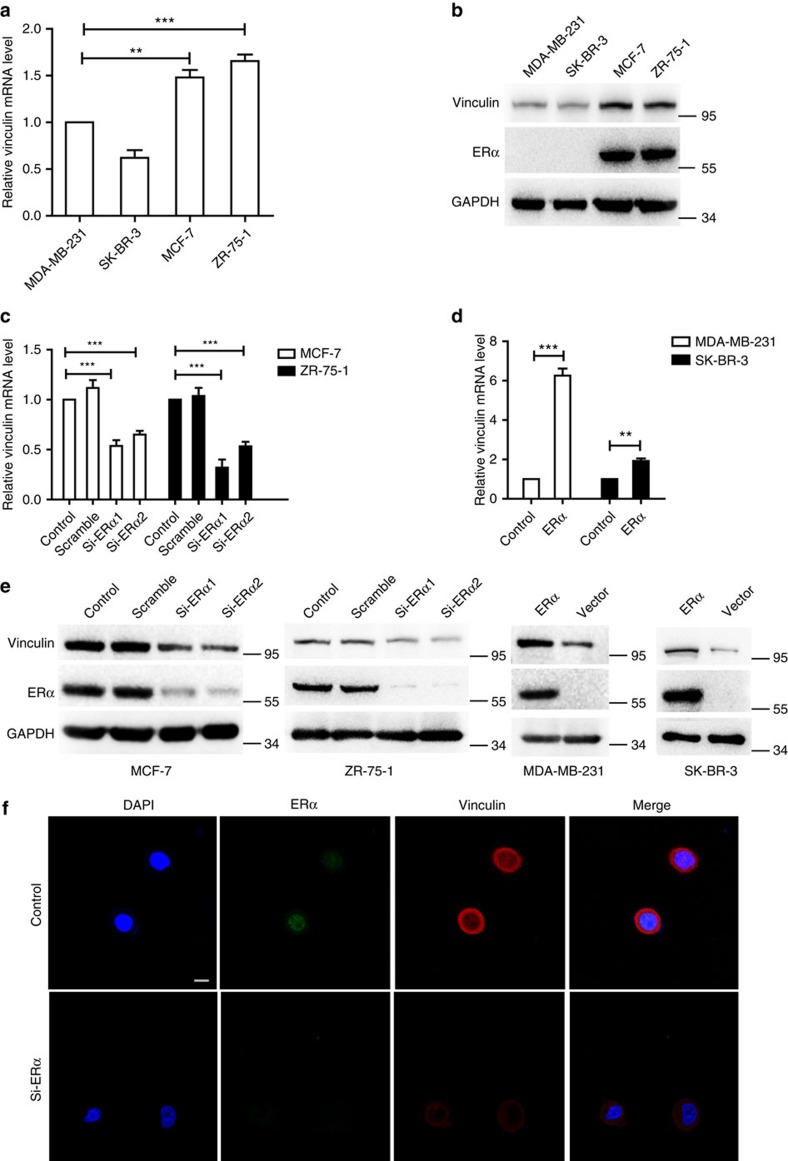
ERα upregulates the expression of vinculin in breast cancer cells.(a) Real-time PCR detecting the transcription levels of vinculin in breast cancer cell lines. The results were normalized to GAPDH (n=3). (b) Western blotting was conducted to detect the protein levels of vinculin and ERα in four breast cancer cell lines. (c) MCF-7 and ZR-75-1 cells were transfected with ERα siRNAs or scrambled RNA and subjected to quantitative reverse transcriptase PCR (qRT–PCR) assay (n=3). (d) MDA-MB-231 and SK-BR-3 cells that were transfected with ERα vector or vector subjected to qRT–PCR assay (n=3). (e) Western blotting to detect the protein level of vinculin and ERα protein by the gain or loss of ERα in breast cancer cell lines. (f) Confocal assay for ERα and vinculin expression in MCF-7 (control or si-ERα) cells. Nuclear staining with 4,6-diamidino-2-phenylindole (DAPI) is also shown. Scale bar, 10 μm. (a,c,d) The data are shown as the mean±s.e.m. **P<0.01,***P<0.001 (a,c) ANOVA with Dunnett t-test; (d) unpaired t-test.